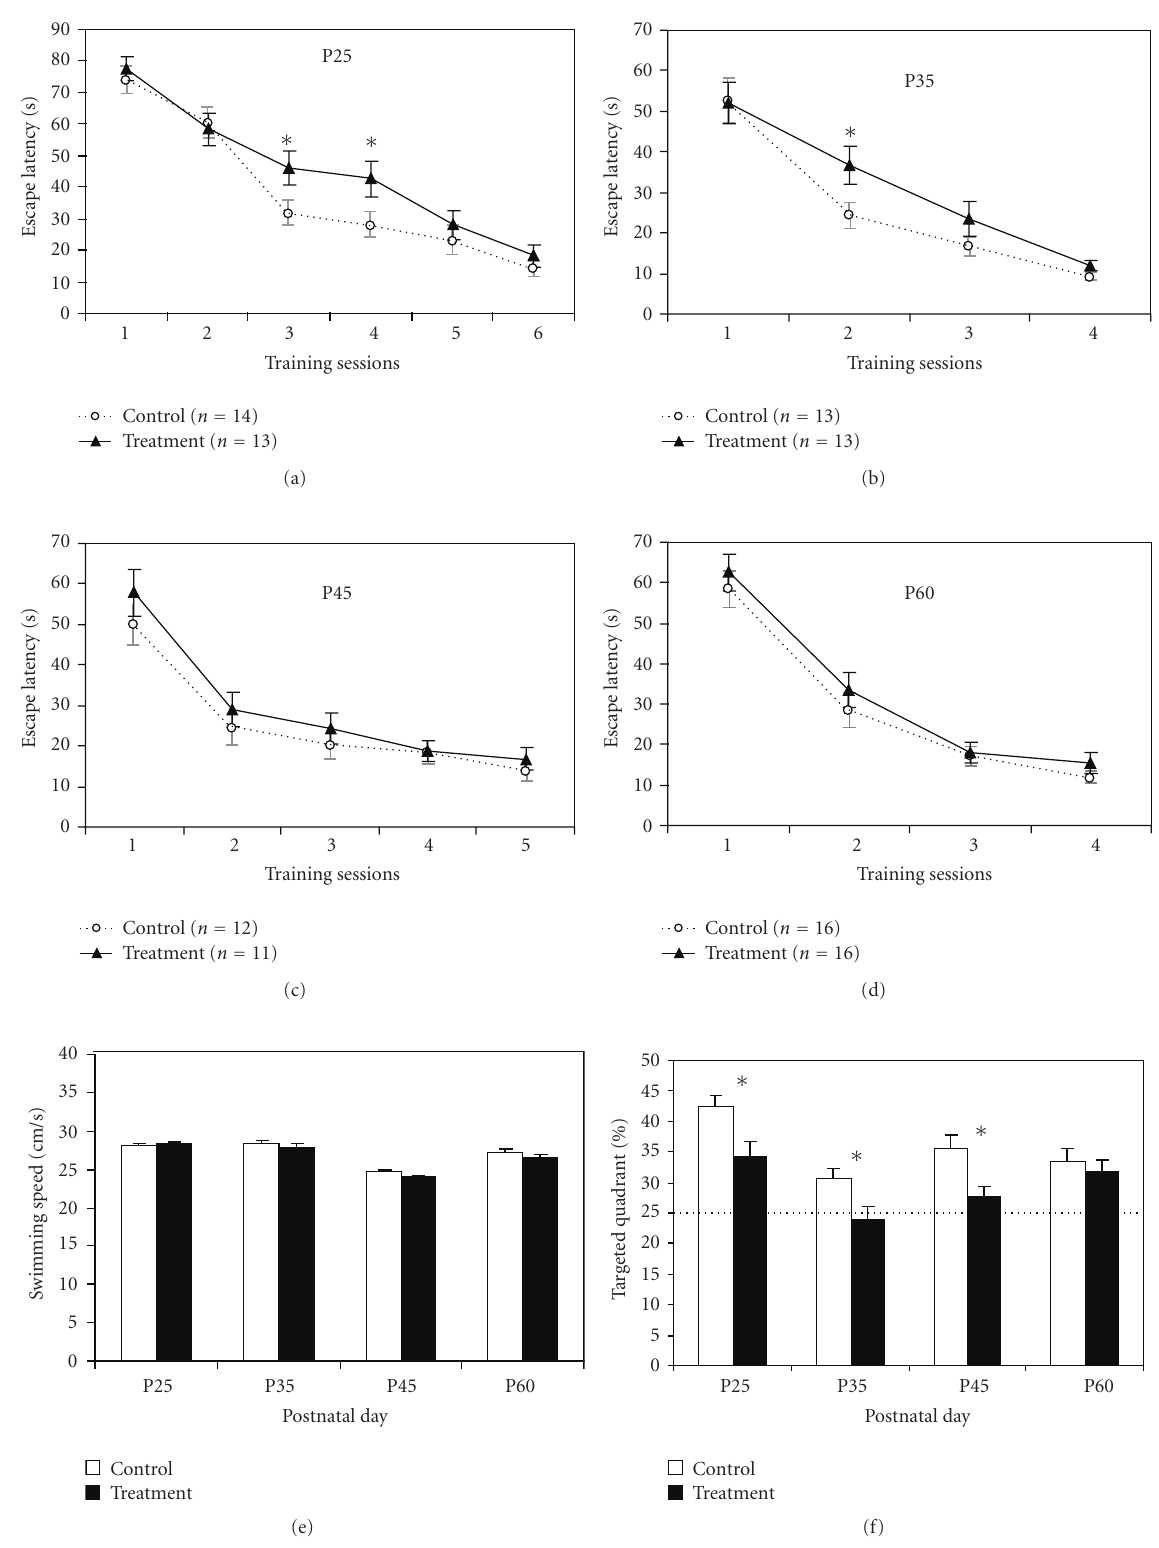
Figure 2: Morris water maze performance in forepaw sensorimotor deprived group (treatment) and sham-operated control group (control) at indicated age. (a) Escape latency for PN25 during training sessions, (b) PN35, (c) PN45, (d) PN60, (e) Swimming speed, and (f) The time spent in searching the targeted quadrant in the probe test for all groups. Data are presented as means ± S.E.M. ∗ Indicates a significant di ff erence between groups for a given age ( P < . 05). Number of rats ( n ) is indicated in the